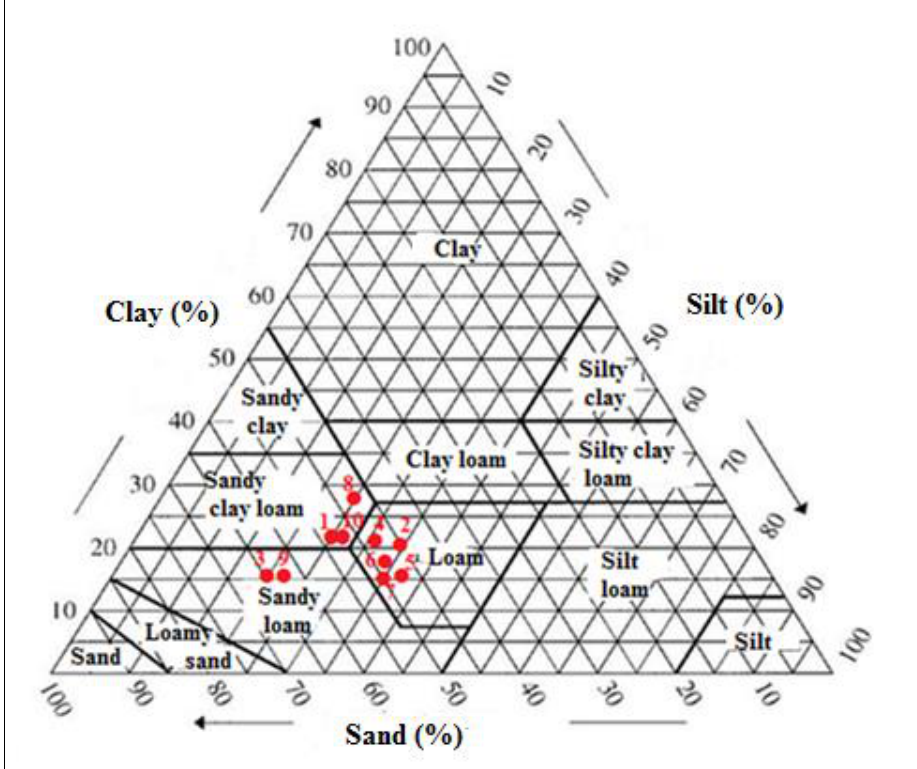
Figure A1. Triangular diagram of textural classes of the studied soils.